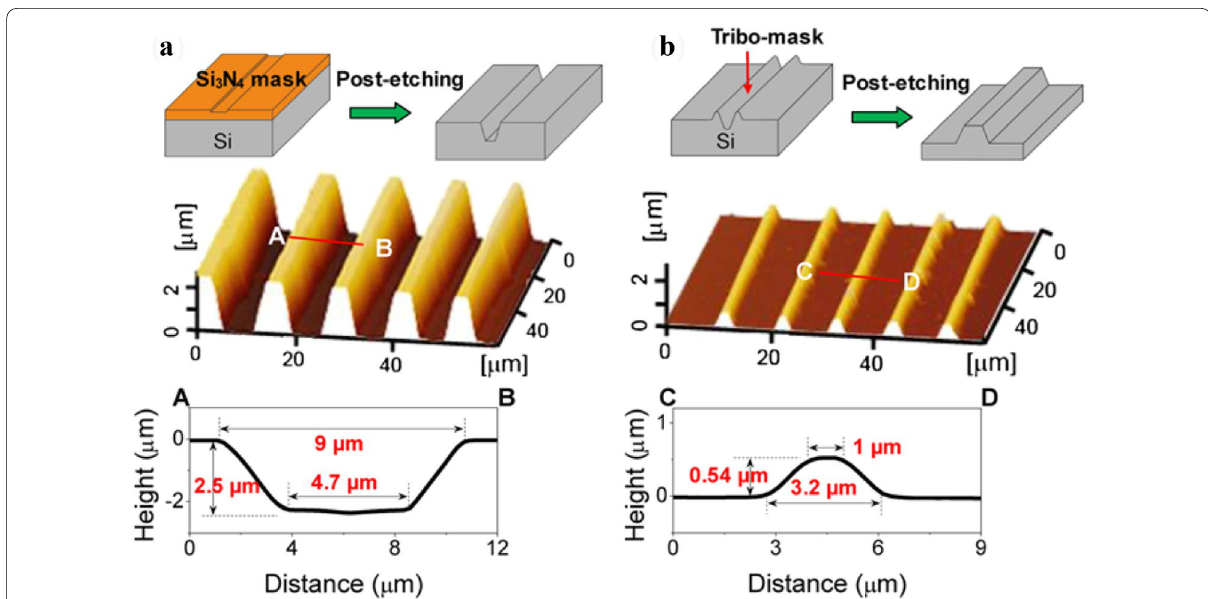
Figure 20 Fabrication of line-array patterns by friction-induced selective etching of Si 3 N 4 mask and traditional friction-induced selective etching [79]: ( a ) Friction-induced selective etching of Si 3 N 4 mask. Line-array pattern with 2.5 μm in depth was fabricated by the scratching on Si 3 N 4 mask under F n 100 m N, post-etching in HF solution for 30 min, and KOH solution for 4 h in sequence, ( b ) Traditional friction-induced selective etching = · (Line-array pattern with 0.54 μm in height fabricated by scratching under F n